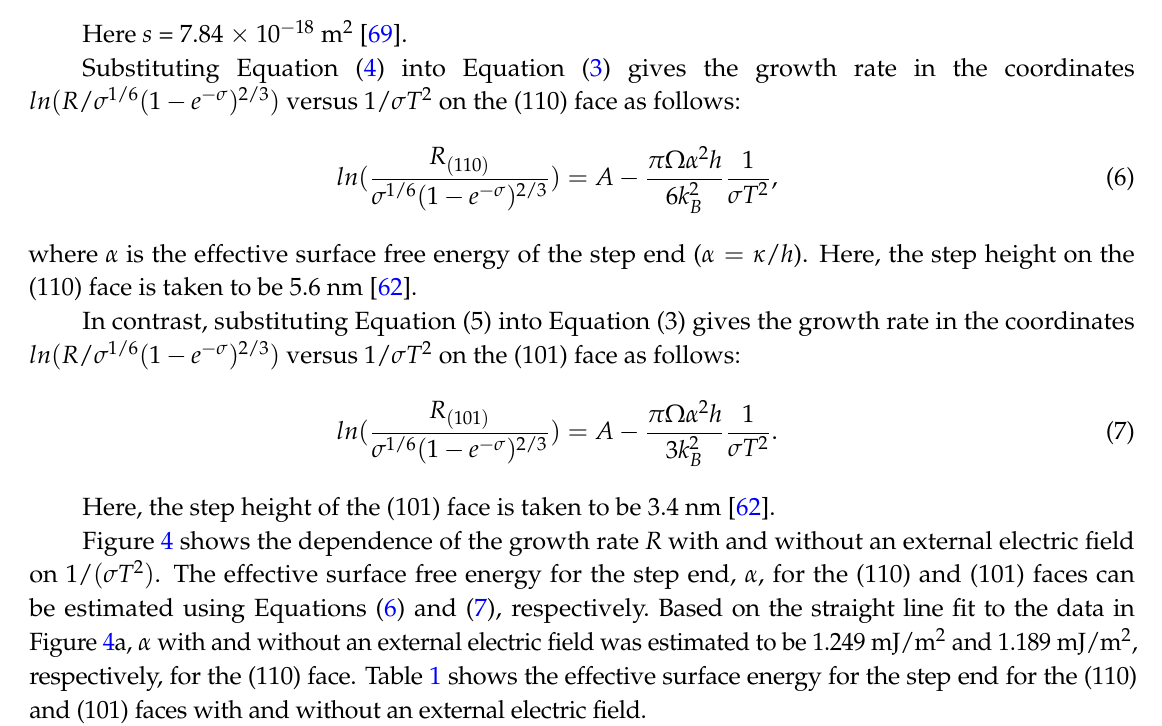
Table 1. Effective surface energy for the step end α for the (110) and (101) faces of tetragonal HEW lysozyme crystals grown with and without an external electric